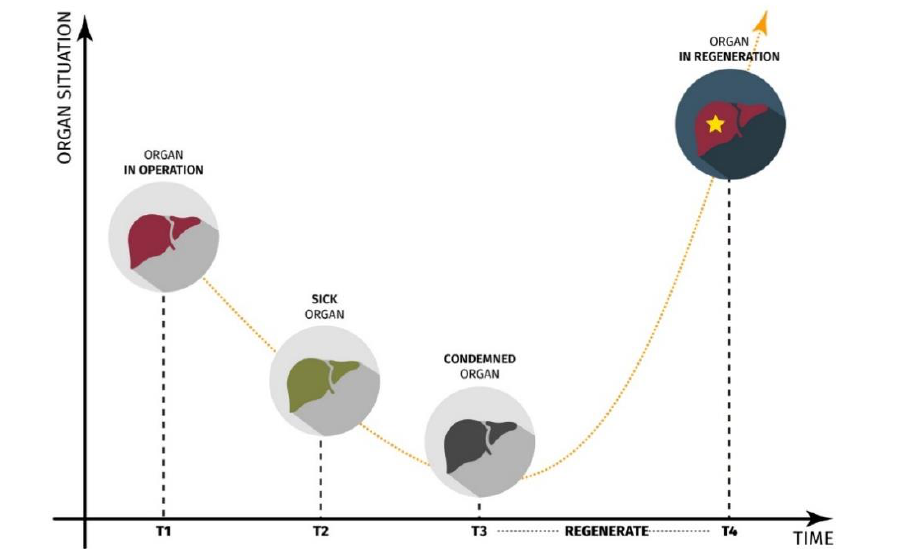
Figure 1. Regeneration process developed on the treatment of "weakened organisms". Source: